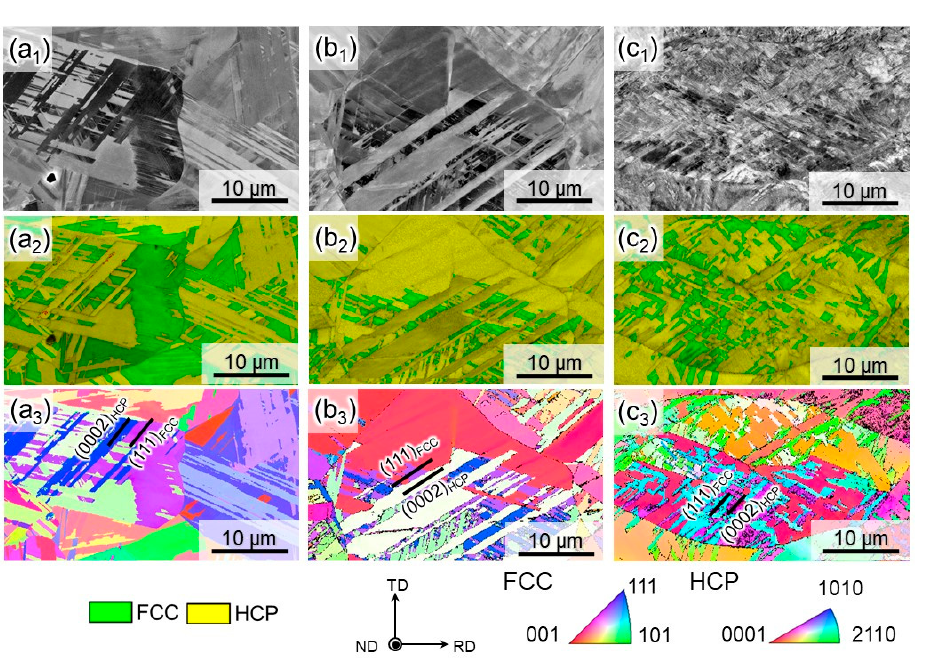
Figure 4. Schematic diagrams of the heat treatment history and expected microstructures for ( a ) low-temperature annealing and ( b ) ausforming. Highlighted regions in the schematic illustration of the fractured specimens indicate the targets of the present observations.